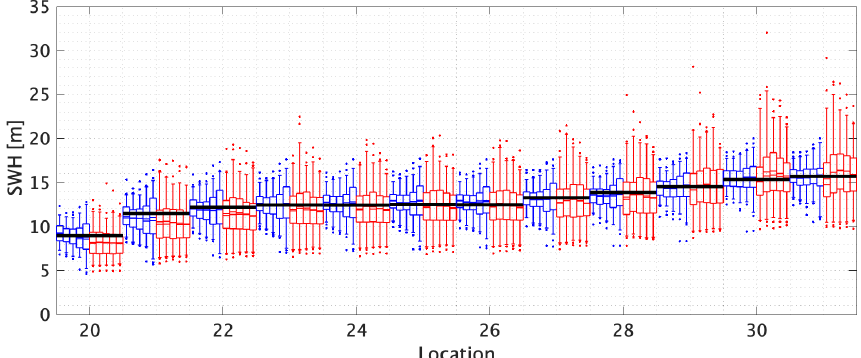
Figure 7. The 500-year return value for SWH using maximum likelihood estimation for the line transect. The x axis gives the reference numbers of the 12 locations on the transect. Briefly, for each location, blue and red box–whiskers summarize the estimated return value from STM-E and single-location analysis respectively; see caption of Fig. 6 for other details. The black horizontal lines for each location correspond to the empirical estimate of the return value obtained directly from the full synthetic cyclone data for that location. Water depths at the 12 line transect locations are given in the caption to Fig. 2.